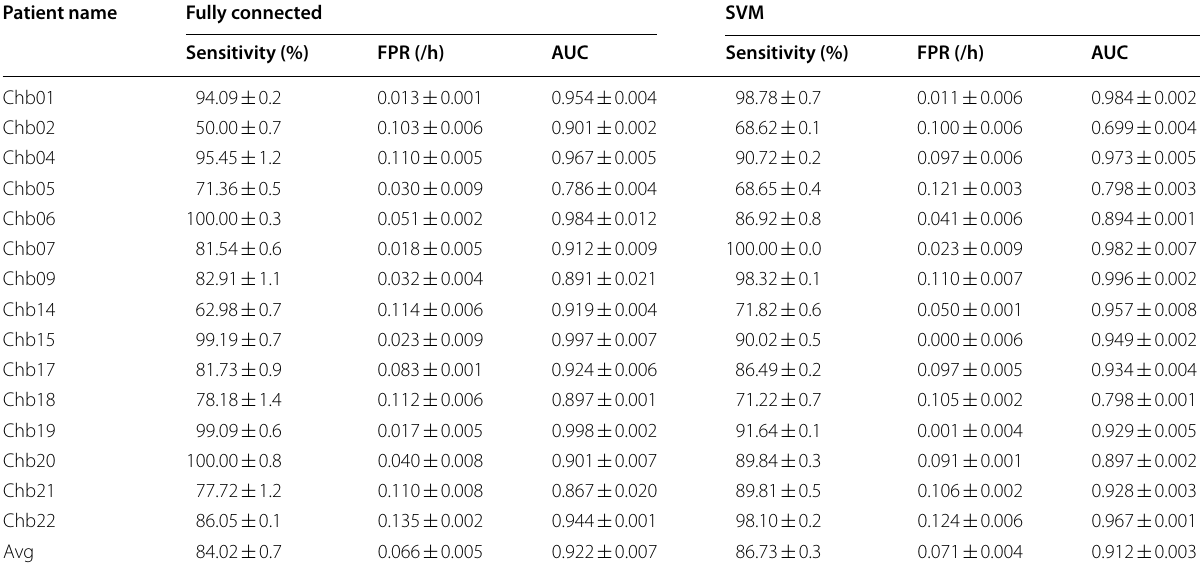
25 min, SPH 5 min) = =